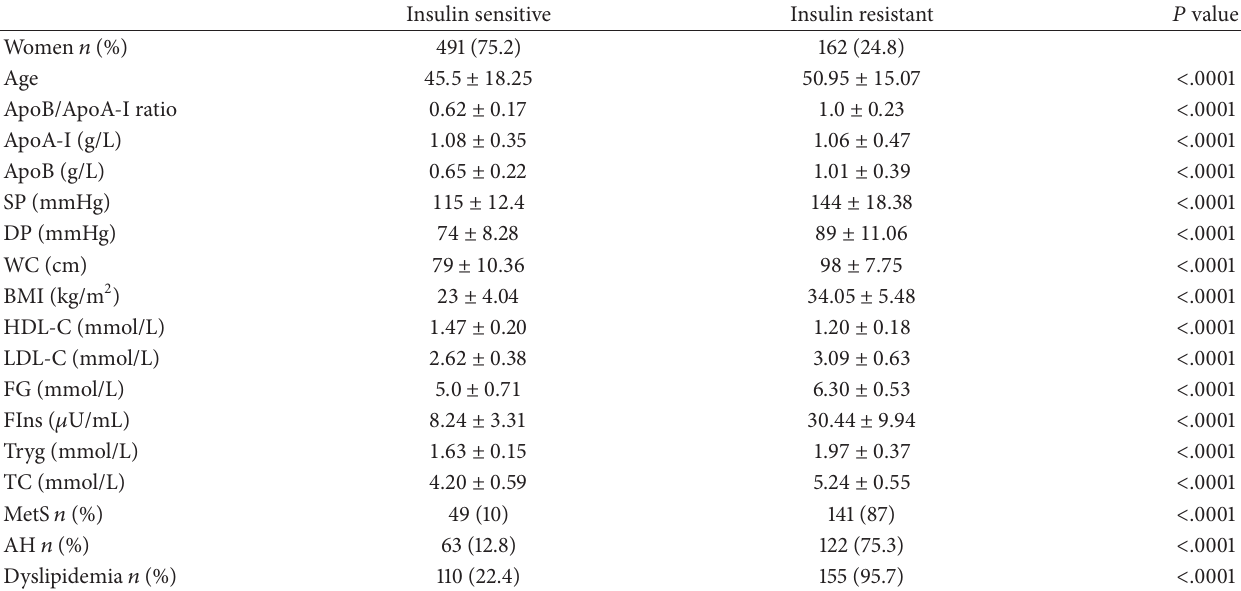
Table 2: Descriptive characteristics between insulin resistant and insulin sensitive